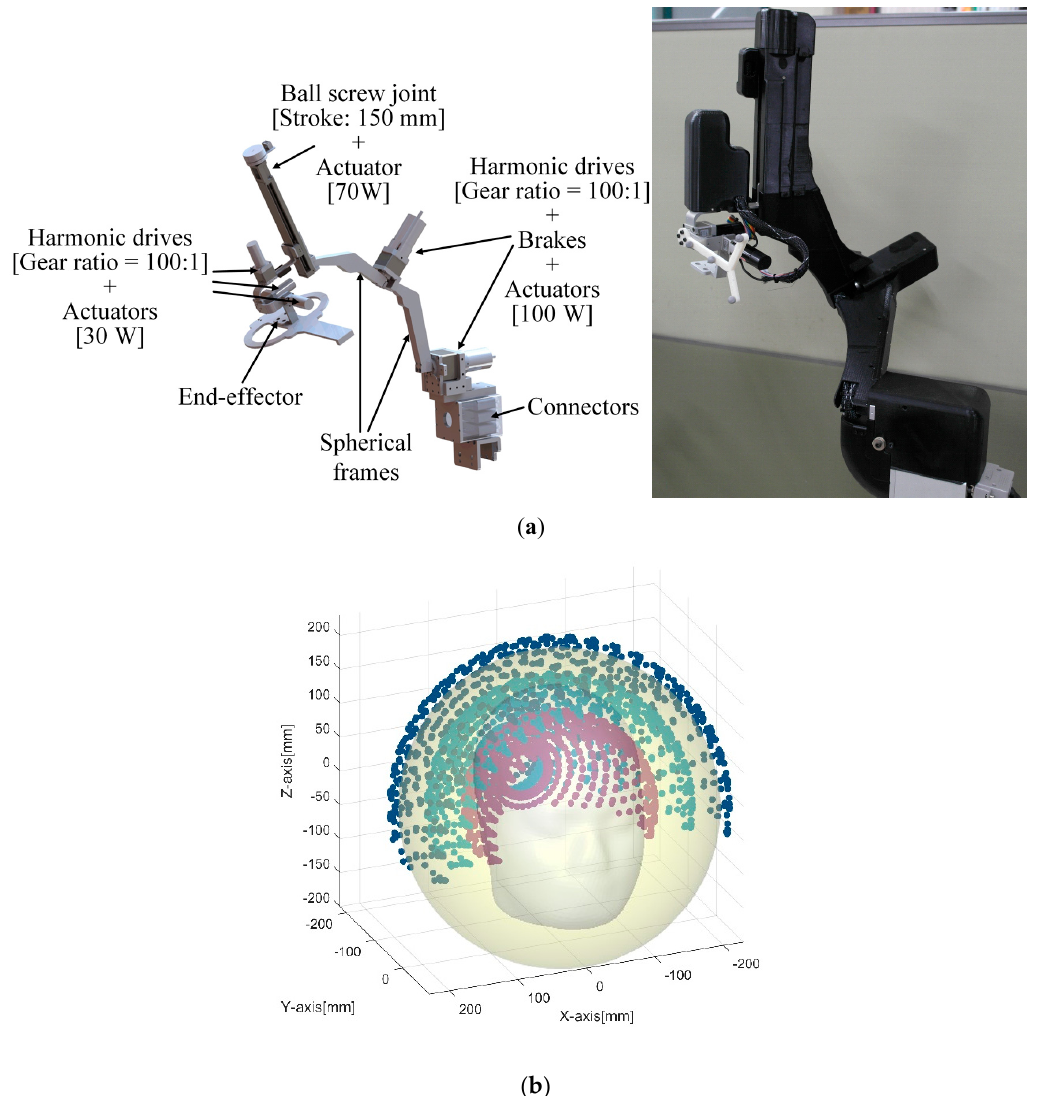
Figure 4. ( a ) 3D ‐ model of the spherical robotic positioning device and prototype with enclosure, ( b ) workspace of the device in given conditions.